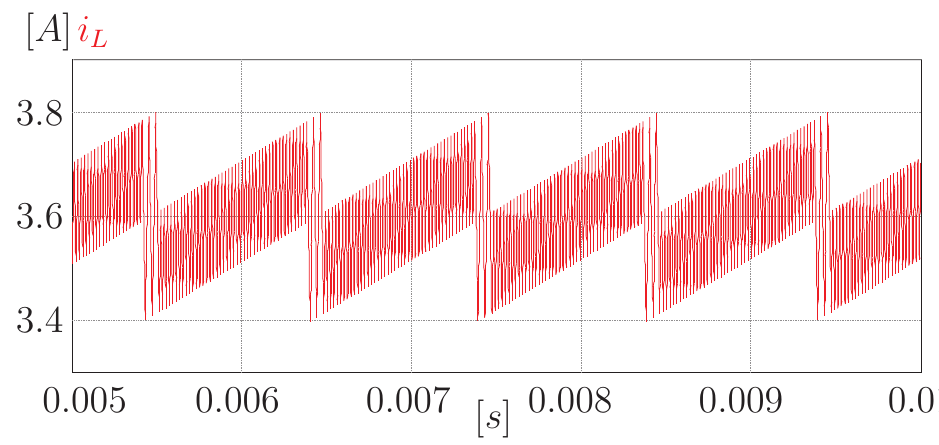
Figure 12. Zoom of the current trough inductor.